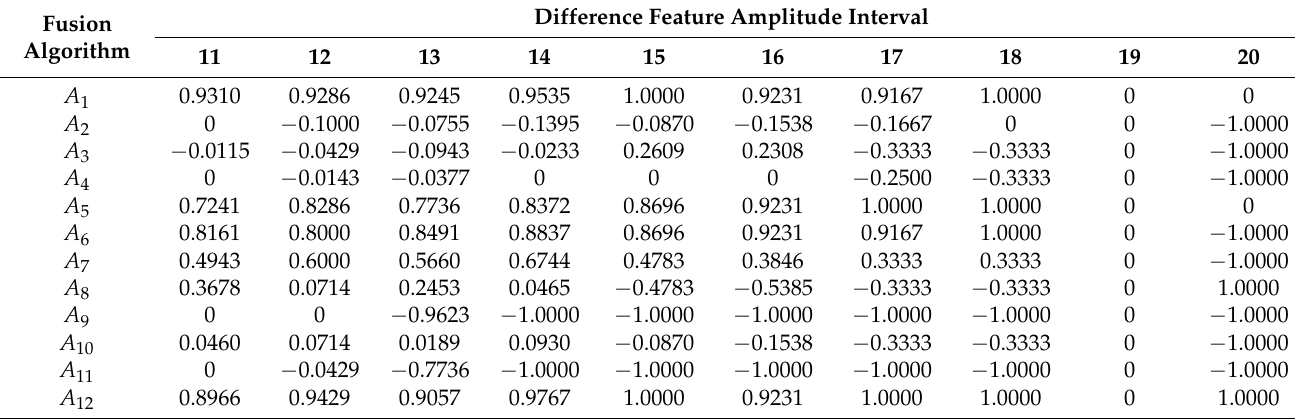
Table 3. Score results in the range of the 11st of difference feature amplitude interval through the 20th interval. Fusion